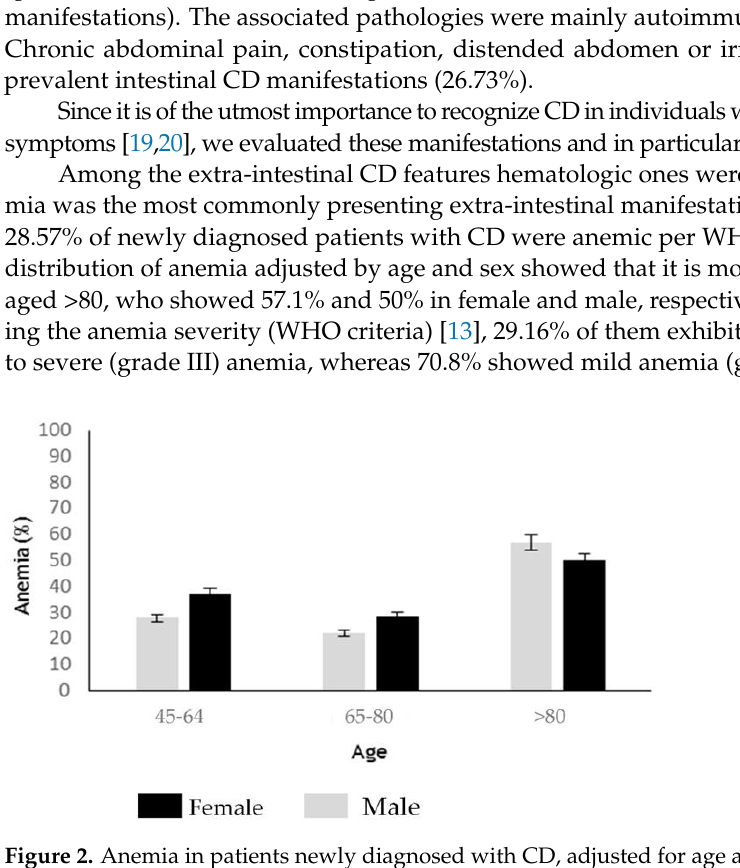
Figure 2. Anemia in patients newly diagnosed with CD, adjusted for age and sex. Data is shown as the mean ± SD. Anemia was established according to the WHO criteria [13]. Abbreviations: CD, Celiac disease; SD, Standard deviation; WHO, World Health Organization.